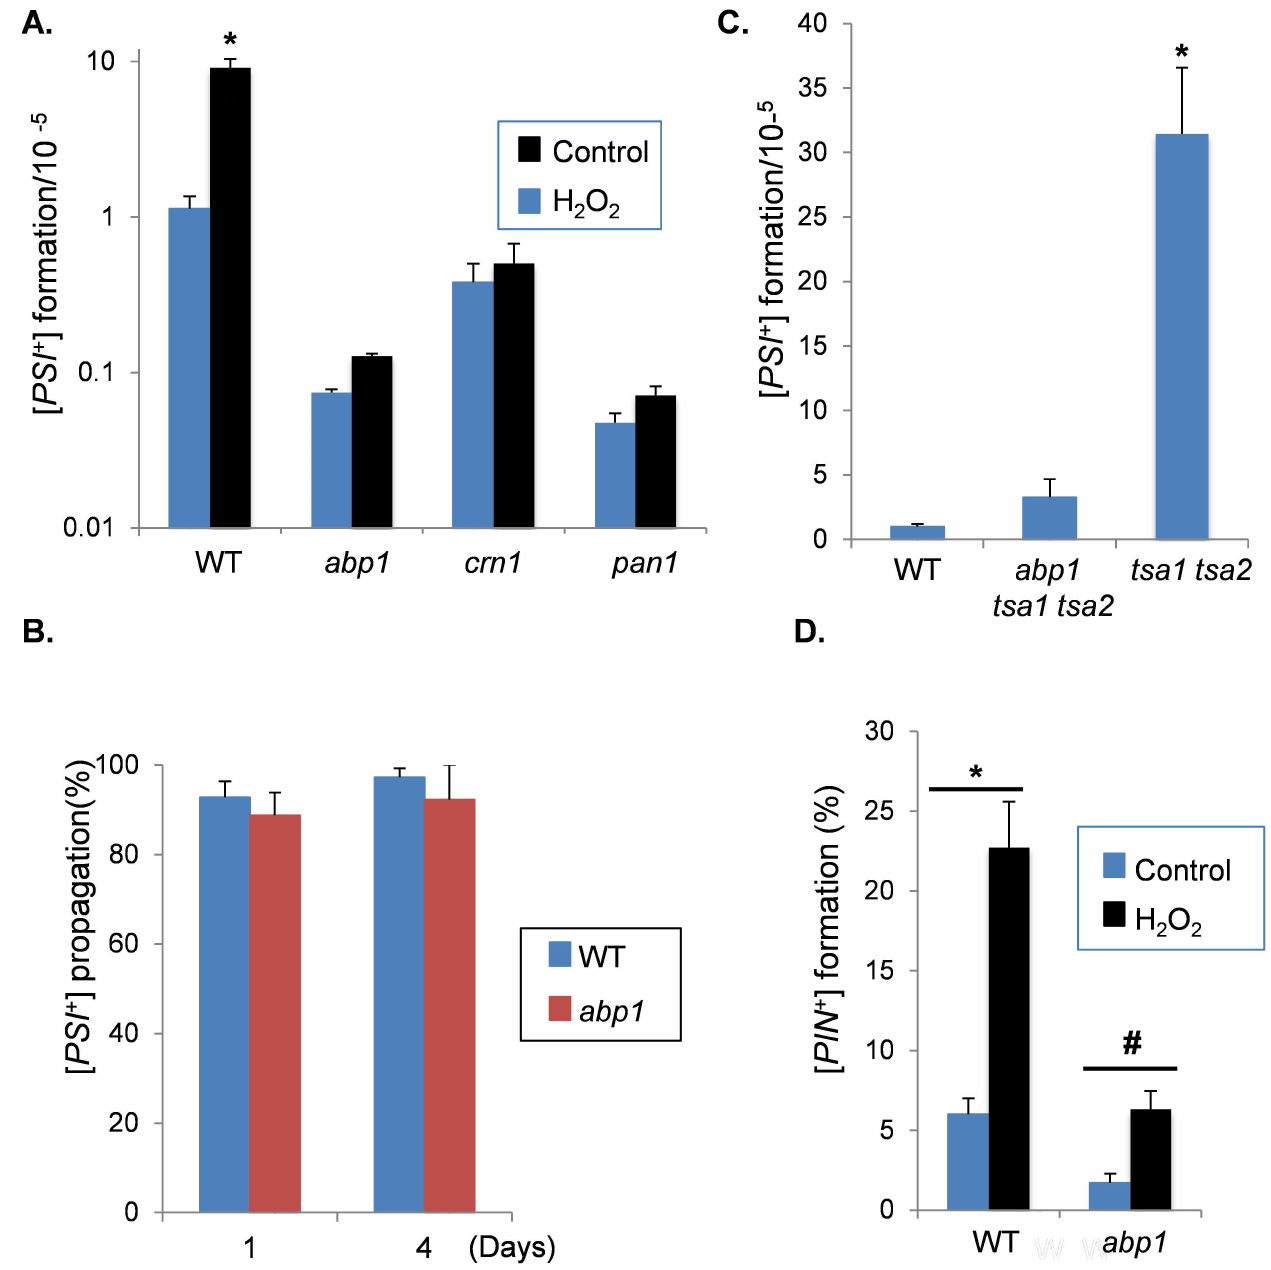
Fig 2. Reducedfrequency of [ PSI + ] formation in corticalactincytoskeleton mutants. A. Thefrequencyof denovo [ PSI + ] prionformationwas quantifiedin wild-type abp1 , crn1 ,and pan1 mutantstrainsgrownin thepresenceor absenceof 100 μ Mhydrogen peroxidefor 20 hours.[ PSI + ] formationwasquantifiedusingthe ade1-14 mutantalleleby growthonmedialackingadenineanddifferentiated from nucleargenemutationsbytheir irreversible elimination inGdnHCL.Datashownare themeansof at leastthreeindependentbiological repeatexperiments expressed as thenumberof coloniesper10 5 viablecells.Error barsdenotestandarddeviation; * marksstatistical significanceat p < 0.01. B. [ PSI + ] propagationwasscoredby culturing[ PSI + ]-versionsof wild-type and abp1 mutantstrainsfor four days.[ PSI + ] maintenancewasquantifiedusingthe ade1-14 mutantalleleas aboveandis expressedasthe percentage of [ PSI + ] cellsfrom threeindependent biologicalrepeatexperiments. C. The frequencyof denovo [ PSI + ] prionformationwasquantifiedin wild-type, tsa1tsa2 and tsa1 tsa2abp1 mutants. Errorbarsdenotestandard deviation; * marksstatisticalsignificance at p < 0.01. D. Denovo [ PIN + ] prionformationwasquantifiedin the wild-type and abp1 mutantstraingrownin the presence or absenceof 100 μ M hydrogenperoxidefor 20 hours.Datashownarethemeansof threeindependent biologicalrepeatsexpressed asthe percentageof viablecells forming[ PIN + ] colonies.Errorbarsdenotestandard deviation( * p < 0.01;# p < 0.05).